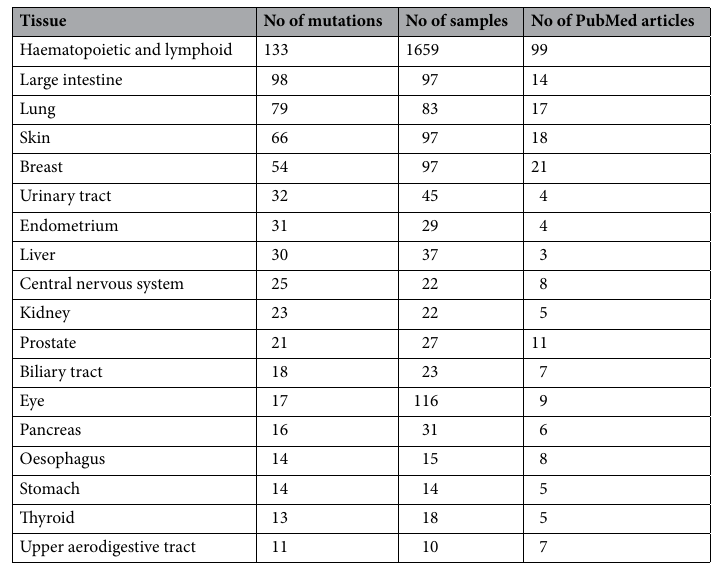
Table 2. The top 18 tissues associated with SF3B1 mutations based on number of mutations, samples, and PubMed articles, collectively. Data are listed in descending order based on number of mutations.